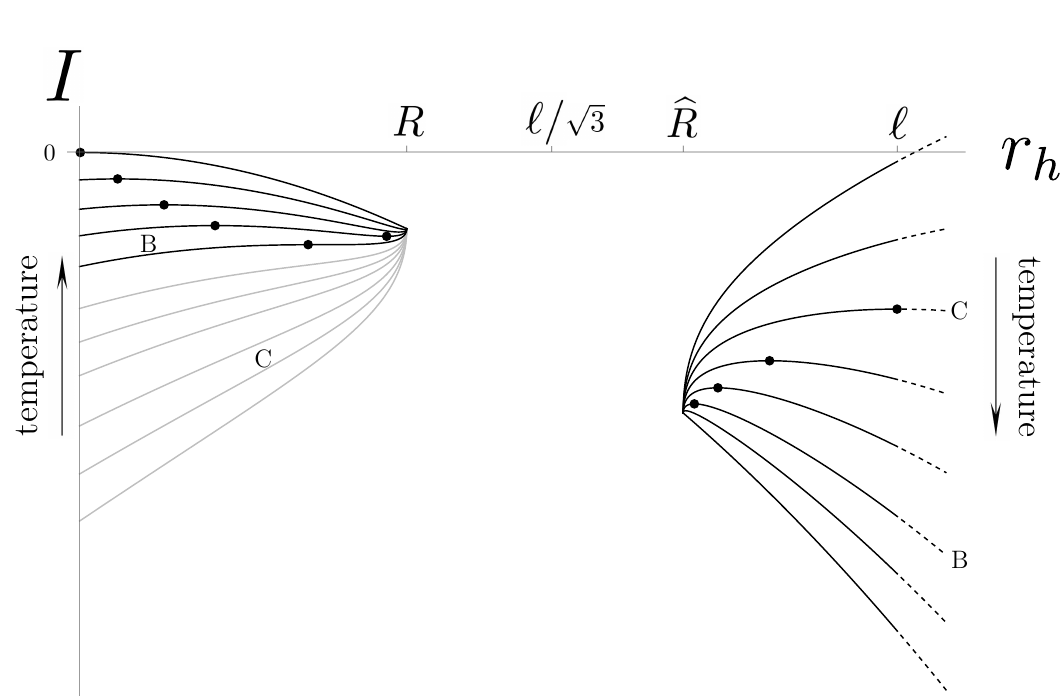
Figure 6. The canonical action as a function of horizon sizes, for b-horizons (the curves on left) and c-horizons (the curves on right), for a case with R < ‘/ action of the endpoints at R and b R is minus the horizon entropy, − πR 2 and − π b R 2 , respectively. The gap between the b-curves and the c-curves decreases as R tends to ‘/ the two branches join at a point with I = − π‘ 2 / 3 . For b-horizon configurations, at temperatures above that of curve B, there are two stationary points, indicated with solid dots, corresponding to “small” and “large” black holes. At lower temperatures there are no stationary points. For c-horizon configurations there is one stationary point at any temperature. For temperatures below that of curve C, the stationary point lies on the dashed part of the graph ( r c >‘ ), corresponding to a negative mass parameter in the